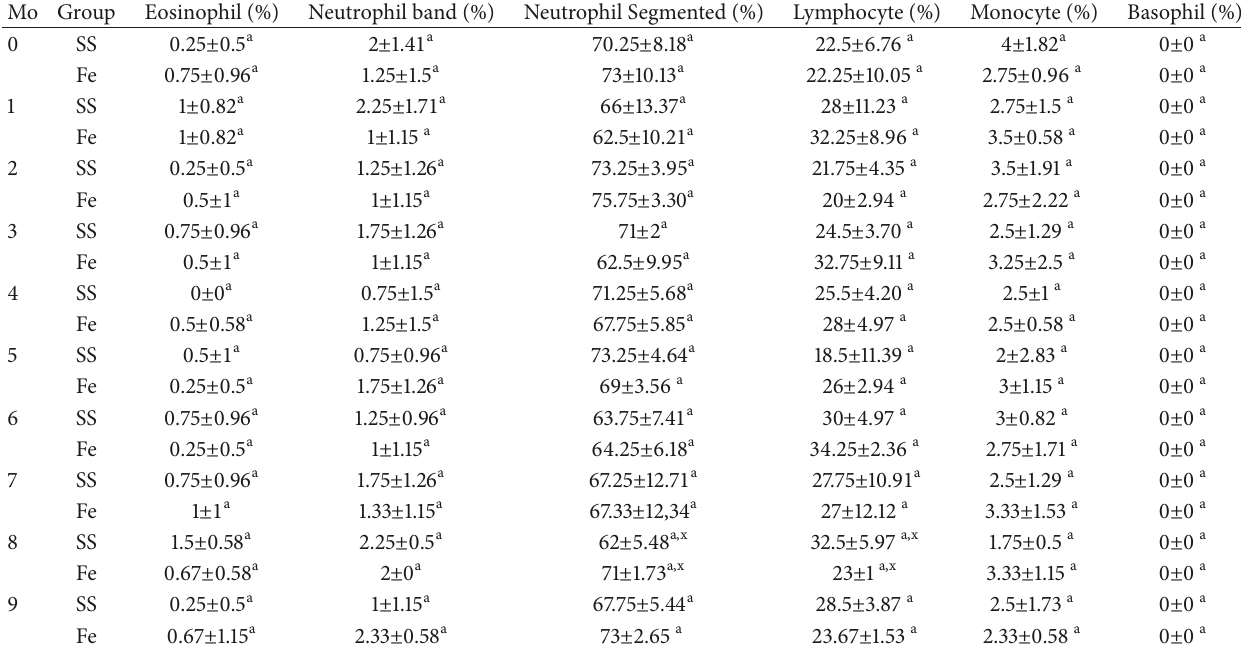
Description: data is presented in the average ± standard deviation. The same superscript letters (a,b,c) in different rows but in the same group showed no significantdifferences(P > 0.05).Thesamesuperscriptletters(x)indifferentrowsandthedifferentgroupshowednosignificantdifferences(P > 0.05).Mo:month.